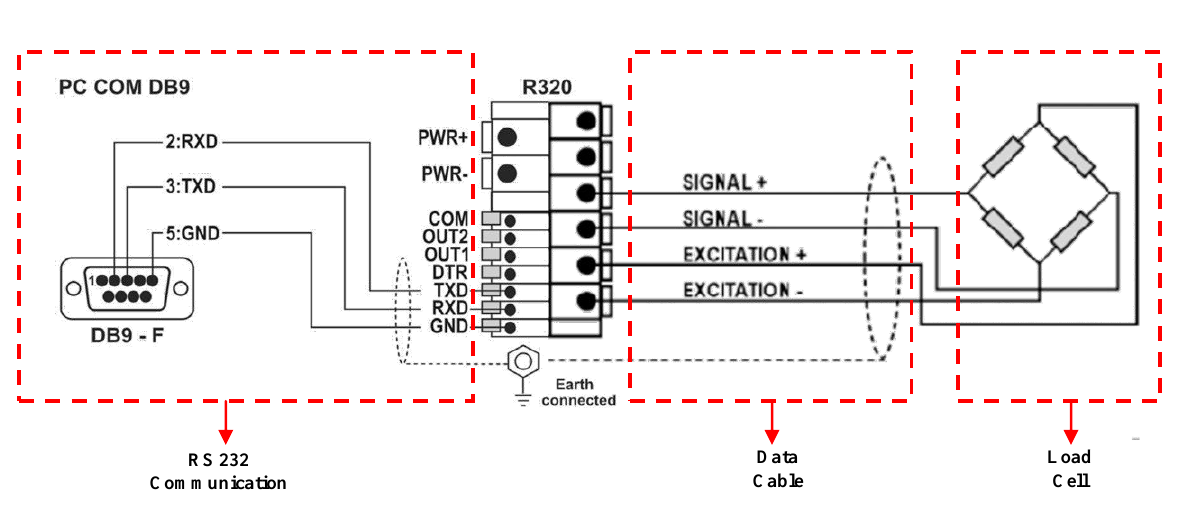
Figure 3. Load cell, indicator and RS232 communication system.